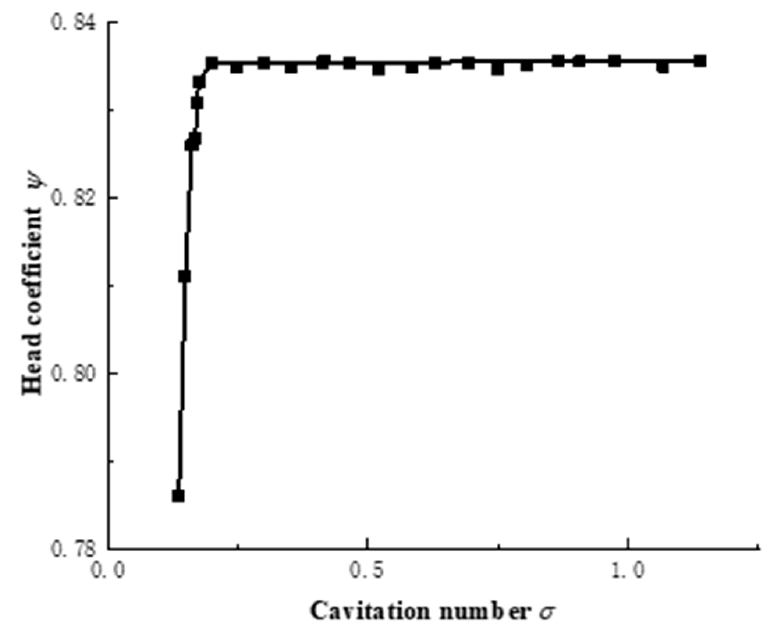
Figure 3. Cavitation performance curve.